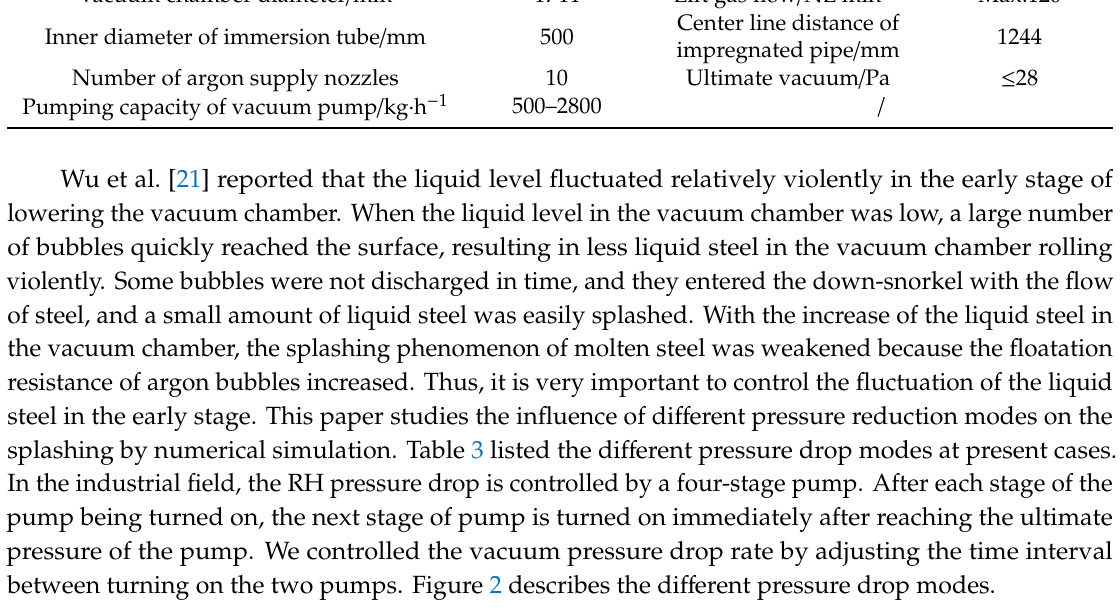
Table 3. Di ff erent pressure drop modes.